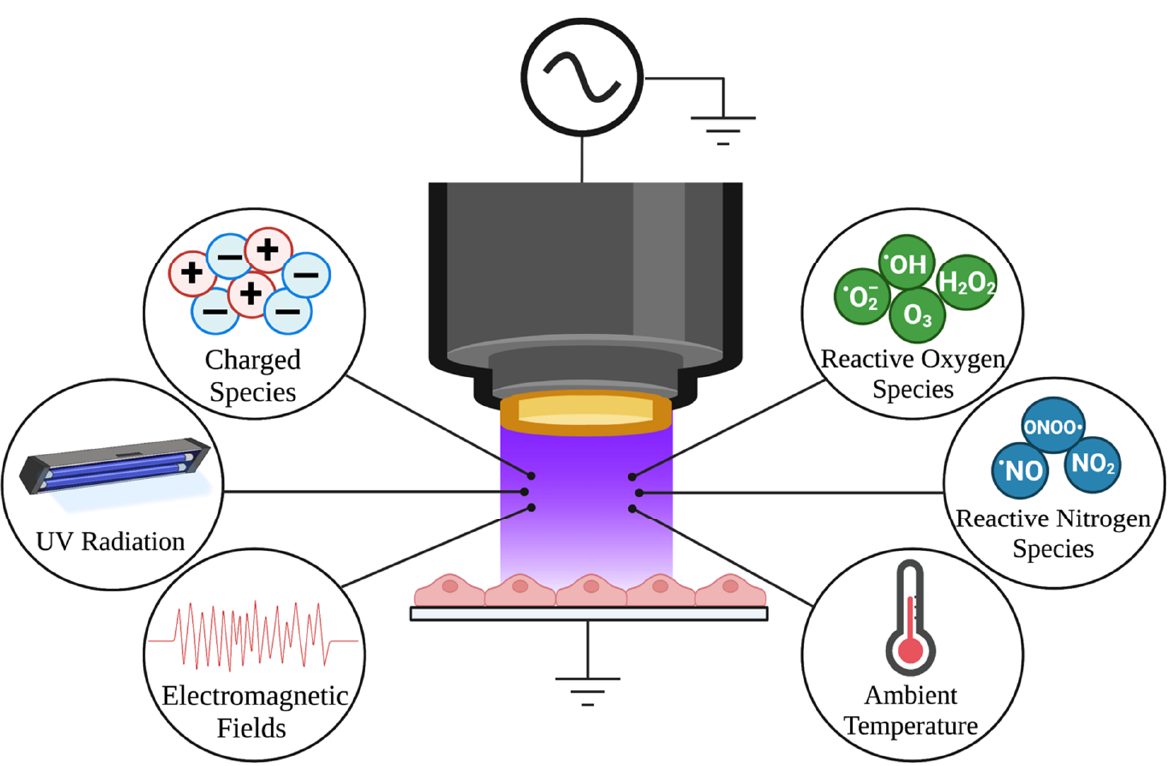
Figure 5. NTP (DBD electrode shown) is a partially ionized gas that generates charged species (elec- trons, and positive- and negative-charged ions), radiation, electromagnetic fields, and reactive spe- cies generated at ambient temperatures. Through collisions between electrons from NTP, and atoms and molecules in the gas and liquid phase, RONS are generated. Following their generation, RONS such as superoxide, nitric oxide, singlet oxygen, ozone, and hydrogen peroxide are delivered to biological targets, which are said to mediate much of NTP’s antiviral effect. The exact composition of RONS delivered can depend on the plasma device and application